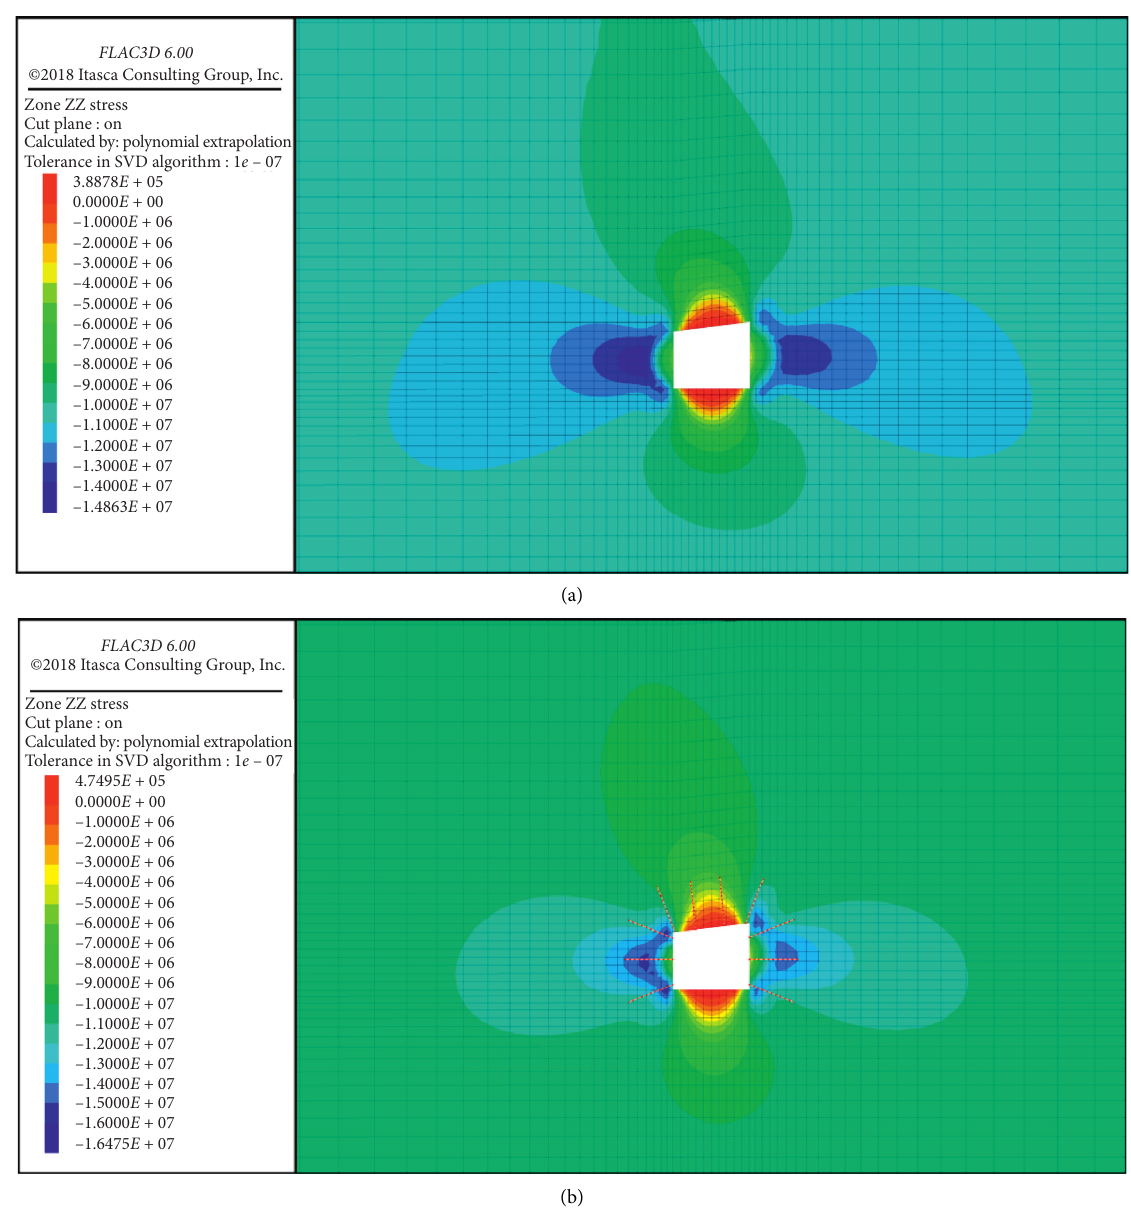
Figure 5: Cloud diagram of maximum principal stress distribution in numerical simulation: (a) original support and (b) reinforced